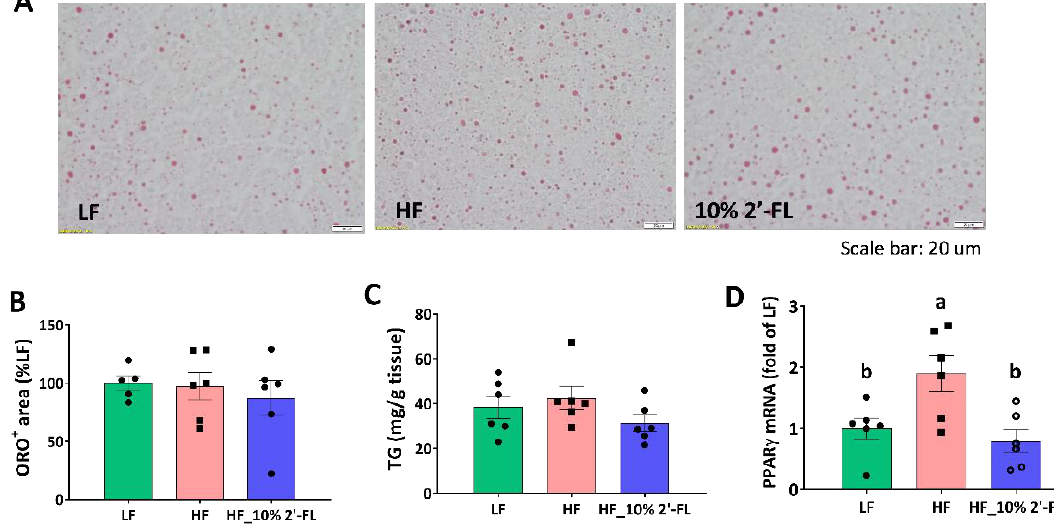
Figure 6. Effect of 10% 2 ′ -FL supplementation on lipid metabolism in the liver. Lipid accumulation ( A , B ), triglyceride (TG, C ), and gene expression of peroxisome proliferator-activated receptor gamma (PPARγ, D ) in the liver of mice fed an LF, HF, or HF_10% 2 ′ -FL diet for six weeks. One-factor ANOVA was performed for statistical analysis. Differences between groups were analyzed by using Tukey’s post hoc tests. Values are means ± SEMs, n = 6/group. Histogram with different letters (a or b) denotes mean values that are statistically different at P < 0.05; for all variables with the same letter, the difference between the means is not statistically significant and if two variables have different letters, they are significantly different. ANOVA, analysis of variance; HF_10 % 2 ′ -FL, HF with 10% 2 ′ -FL ( w / v ) in drinking water; LF, low fat; ORO, Oil Red O; 2 ′ -FL, 2-fucosyllactose.